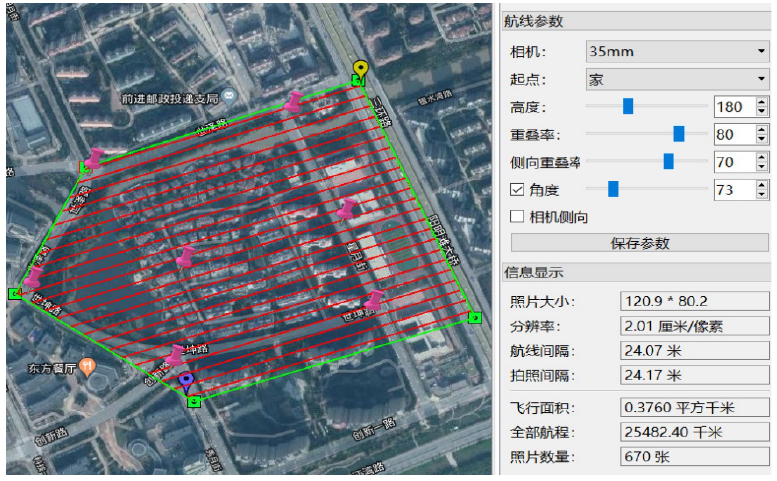
Fig.1 Route planning and image control point layout